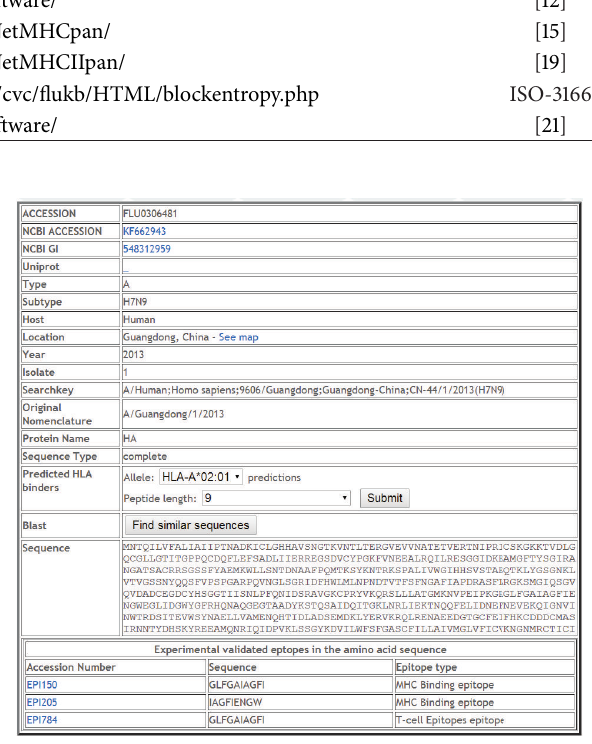
Figure 3: Record FLU0306481, Protein HA representing the 2013 H7N9 outbreak of bird flu in